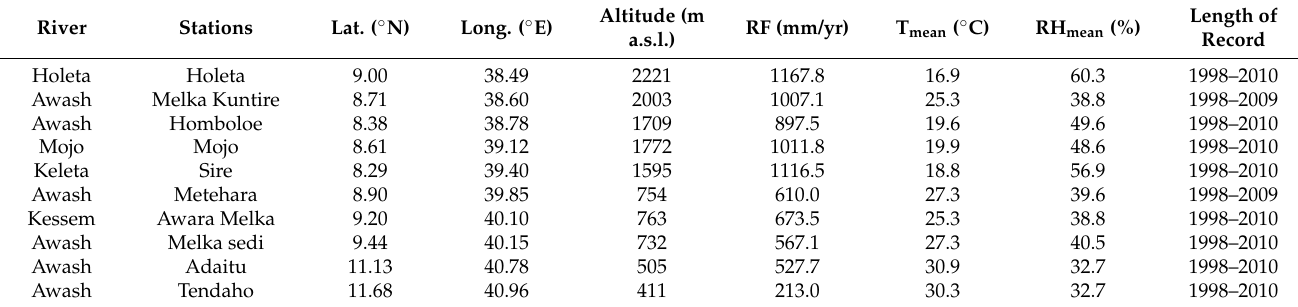
Table 1. Summary of climatic data of the ARB in